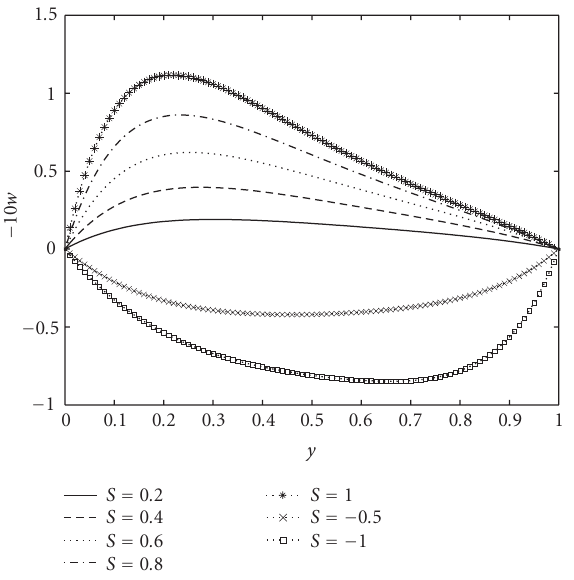
Figure 4.5. Cross-velocity − 10 w for ω = 6 . 0, Re = 5 . 0, z = 0 . 5, t = 0 . 2, (cid:3) = 0 .